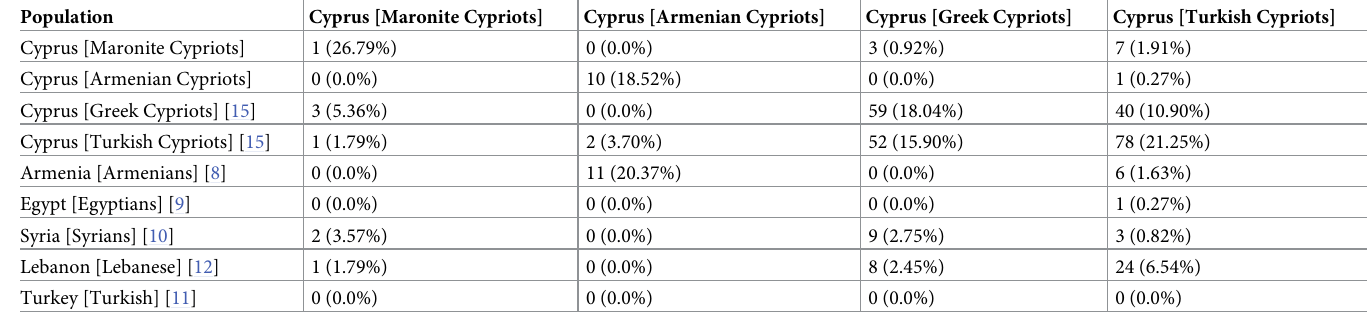
Table 4. Number and percentage of shared haplotypes between & within Cypriots and populations of interest.